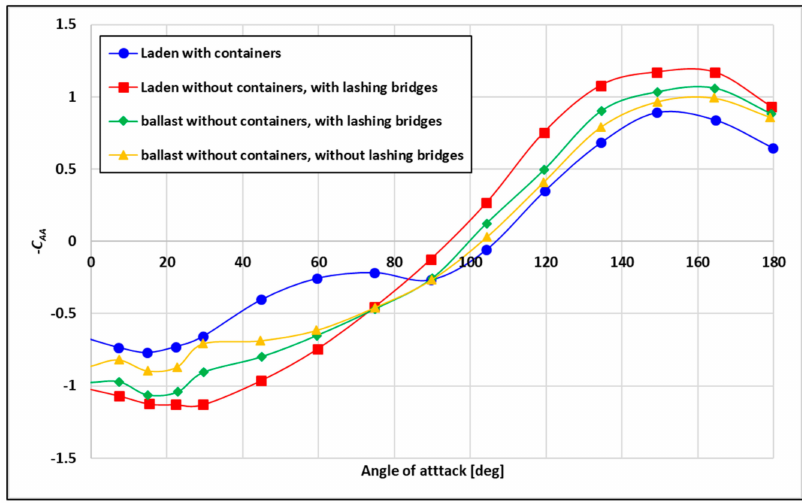
Figure 5. Wind resistance coe ffi cient of the 6800 TEU container